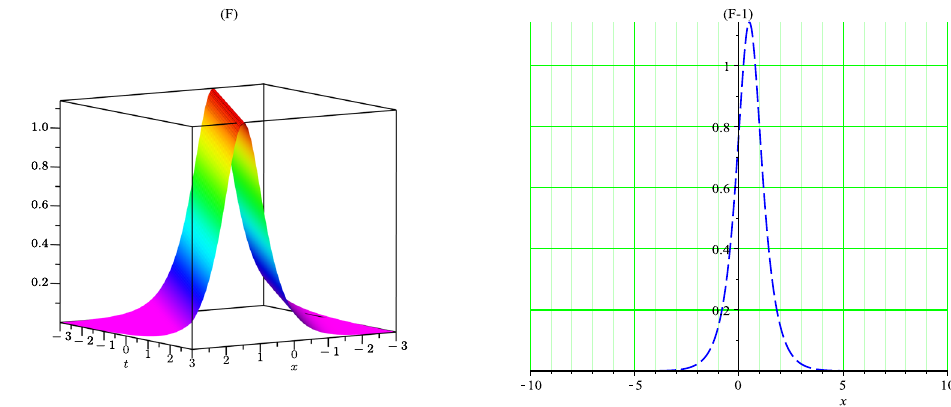
Figure 6: ( F ) 3D graph of ( 71 ) with a 0.3 =